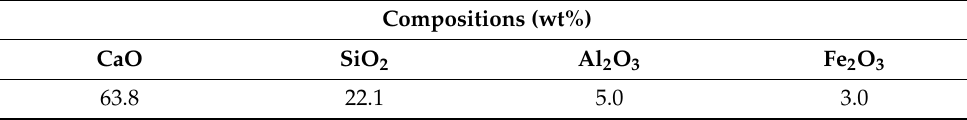
Table 3. Average chemical composition of Portland cement type